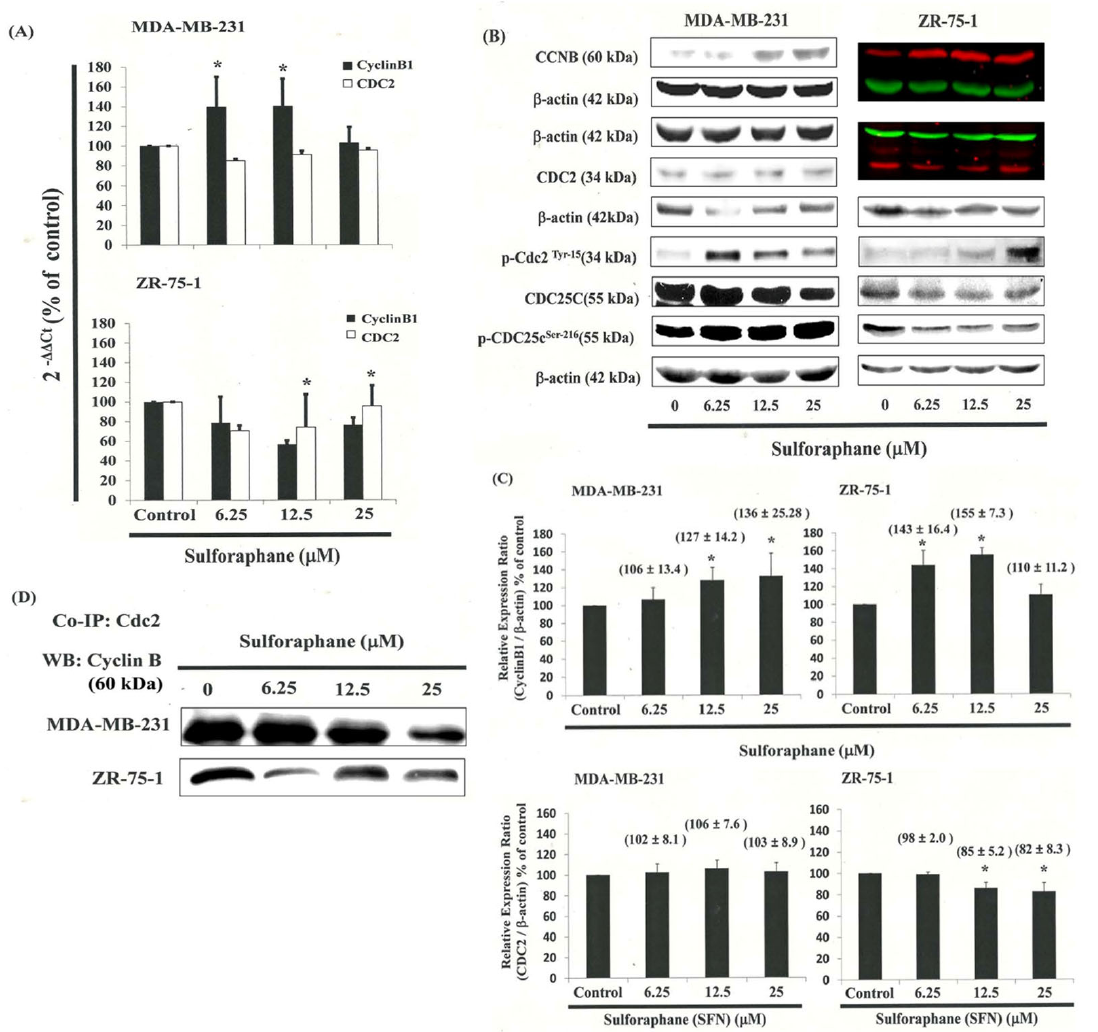
Figure 3. SFN repressed CDC25C activity and enhanced CDC2/cyclinB1 disassociation in MDA- MB-231 and ZR-75-1 cells. Cells were treated with SFN for 24 h, the gene and protein expression was subsequently detected using ( A ) q-RT-PCR and ( B ) Western blot analysis: ( C ) representative blots from three independent experiments. Quantification of band intensities. ( D ) Co-IP of CDC2 and cyclinB1 in breast cancer cell lines treated with SFN. * in each group of bars indicates that the difference resulting from treatment with 0 ì M SFN was significant at p < 0.05. All data are reported as the mean ( ± SEM) of at least three separate experiments.